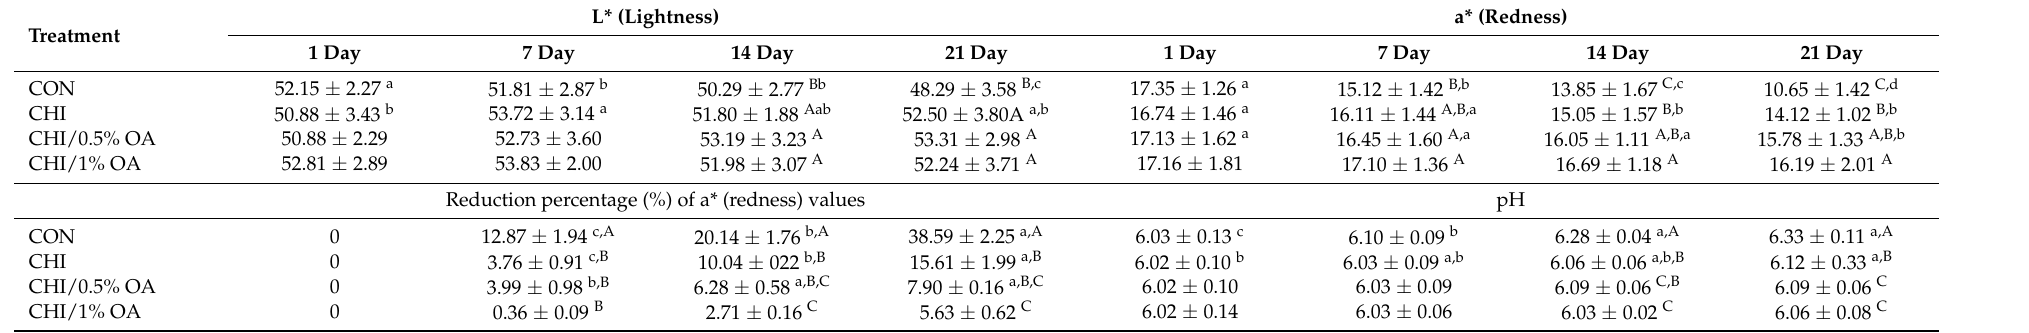
Table 4. Color traits, redness values reduction (%) and pH of coated pork during